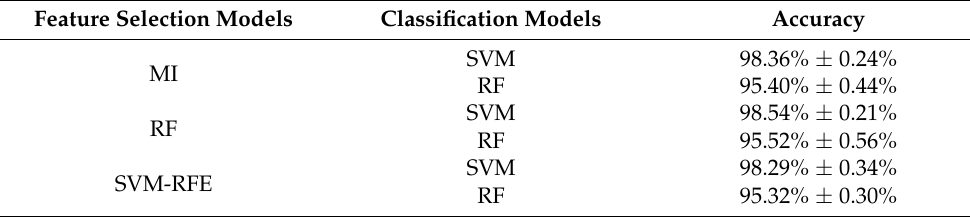
Table 2. Classification accuracy under different feature selection models.